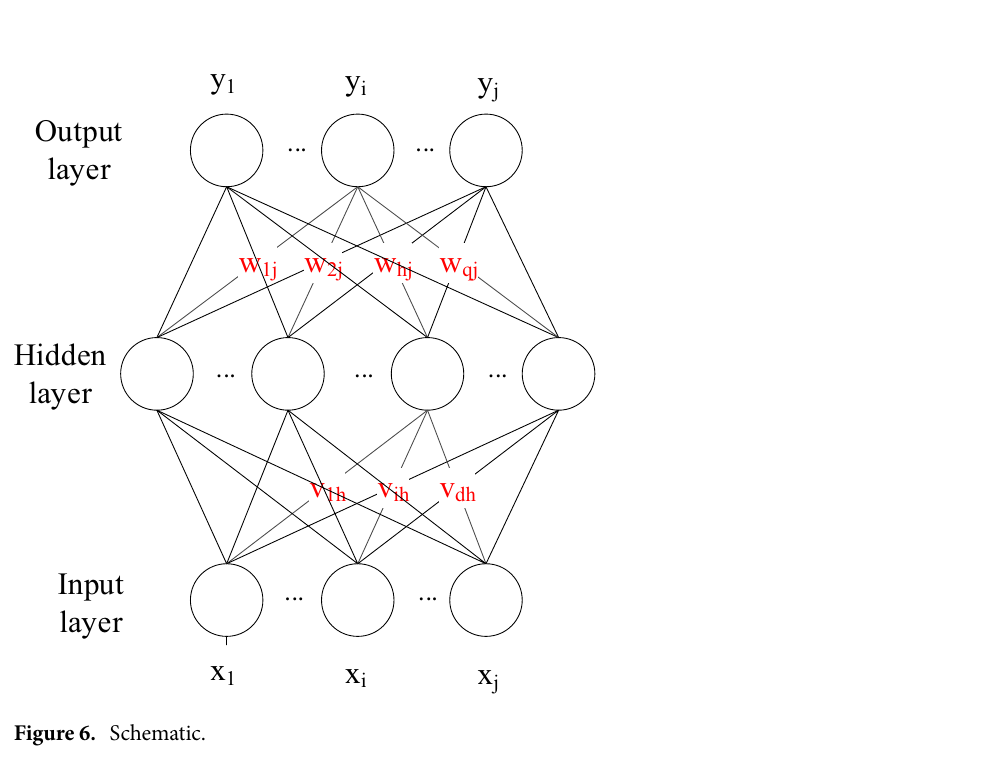
Figure 5. Algorithm solution graph.